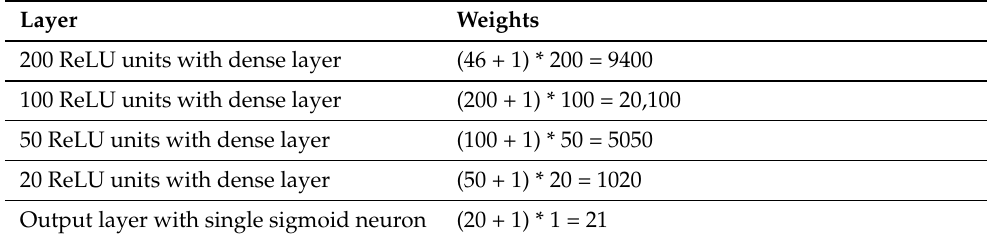
Table 4. Layered-wise details for a fully connected network.